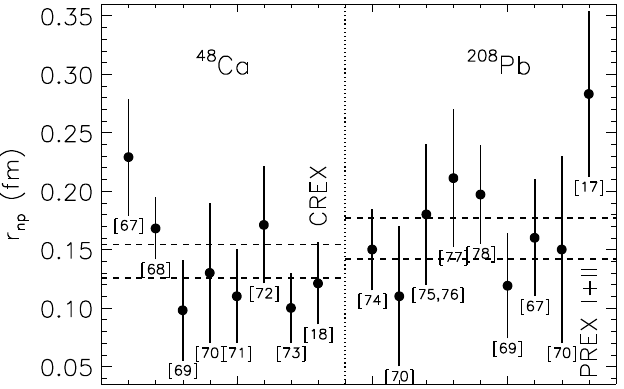
Figure 8. Neutron skin measurements [17,18,70–81] with 68% confidence intervals and citations. Horizontal dashed lines denote ± 1 standard deviations from the weighted means of experiments other than CREX or PREX